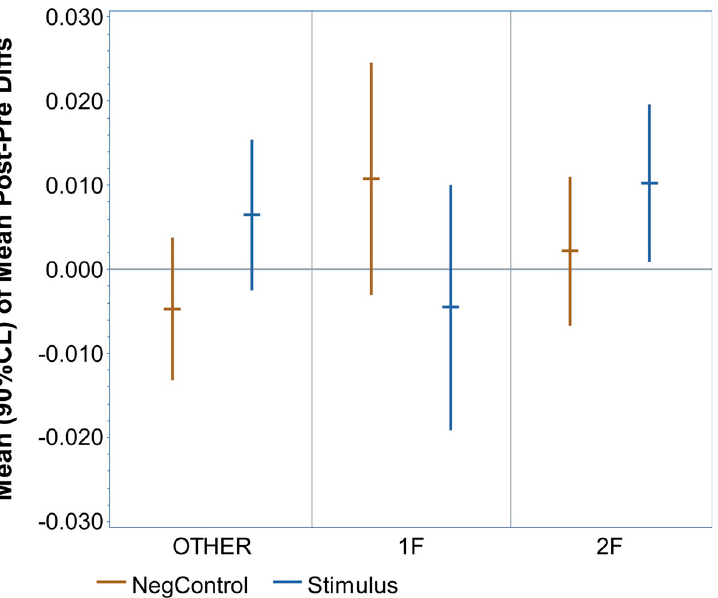
Fig 6. Subgroup analysis of fetal behavioral state. Summary of the statistical subgroup analysis depending on fetal behavioral-state groups using a MF of 27 Hz. The error bars represent the 90% confidence intervals. The most frequent fetal states ‘2F’ (active asleep) and ‘1F’ (quiet asleep) are displayed, all less common fetal states were summarized as ‘OTHER’. Stimulation recordings (‘Stimulus’) and control recordings (‘NegControl’) are displayed.